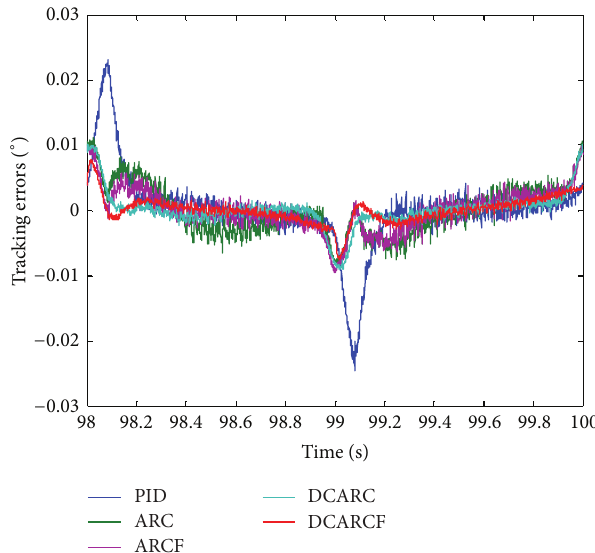
Figure 12: Tracking errors of five controllers during the last cycle in slow tracking case.